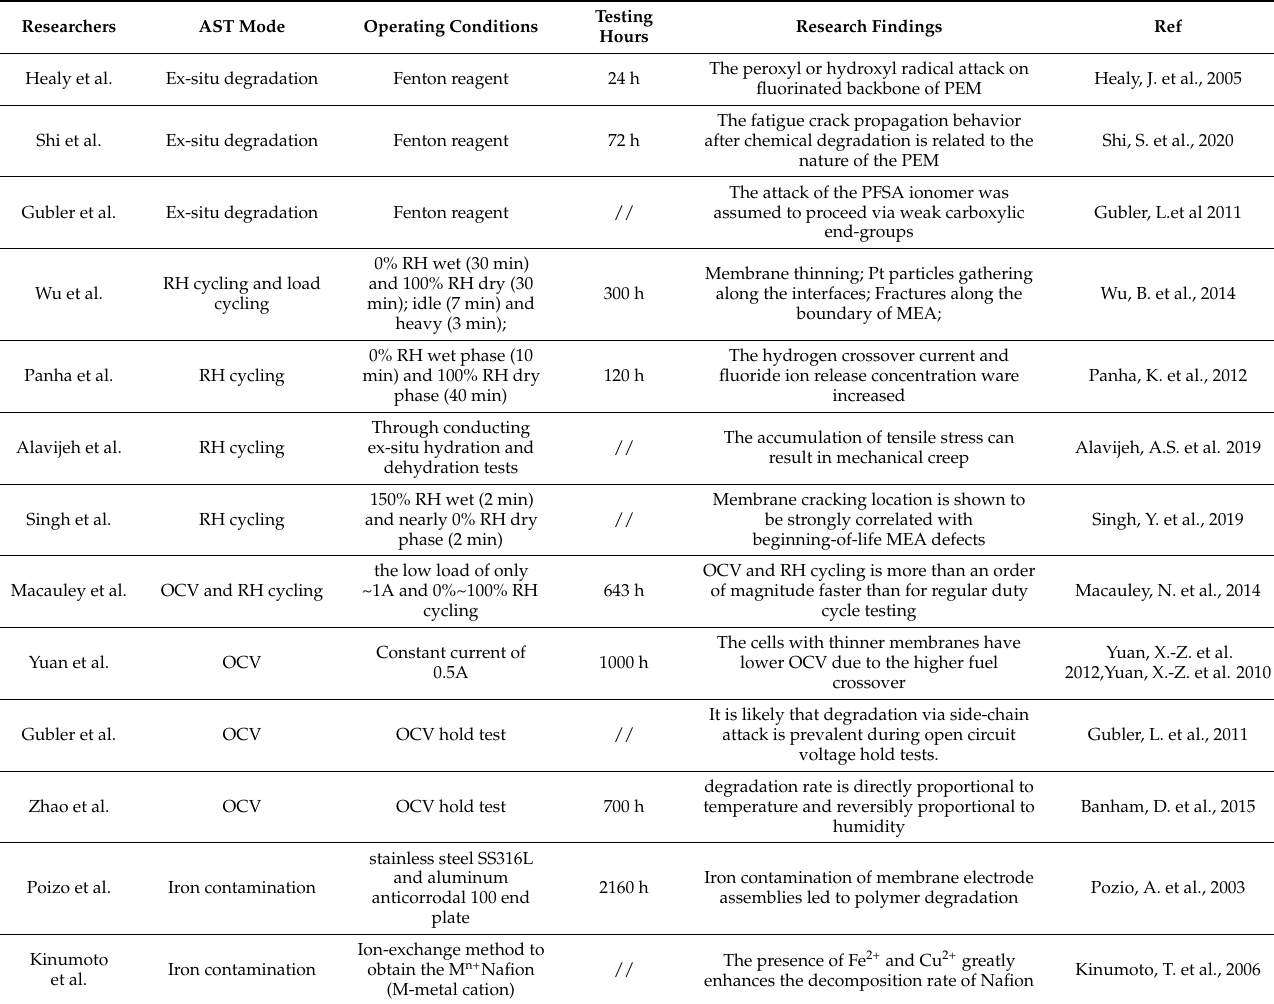
Table 1. Overview of membrane failure in lifetime